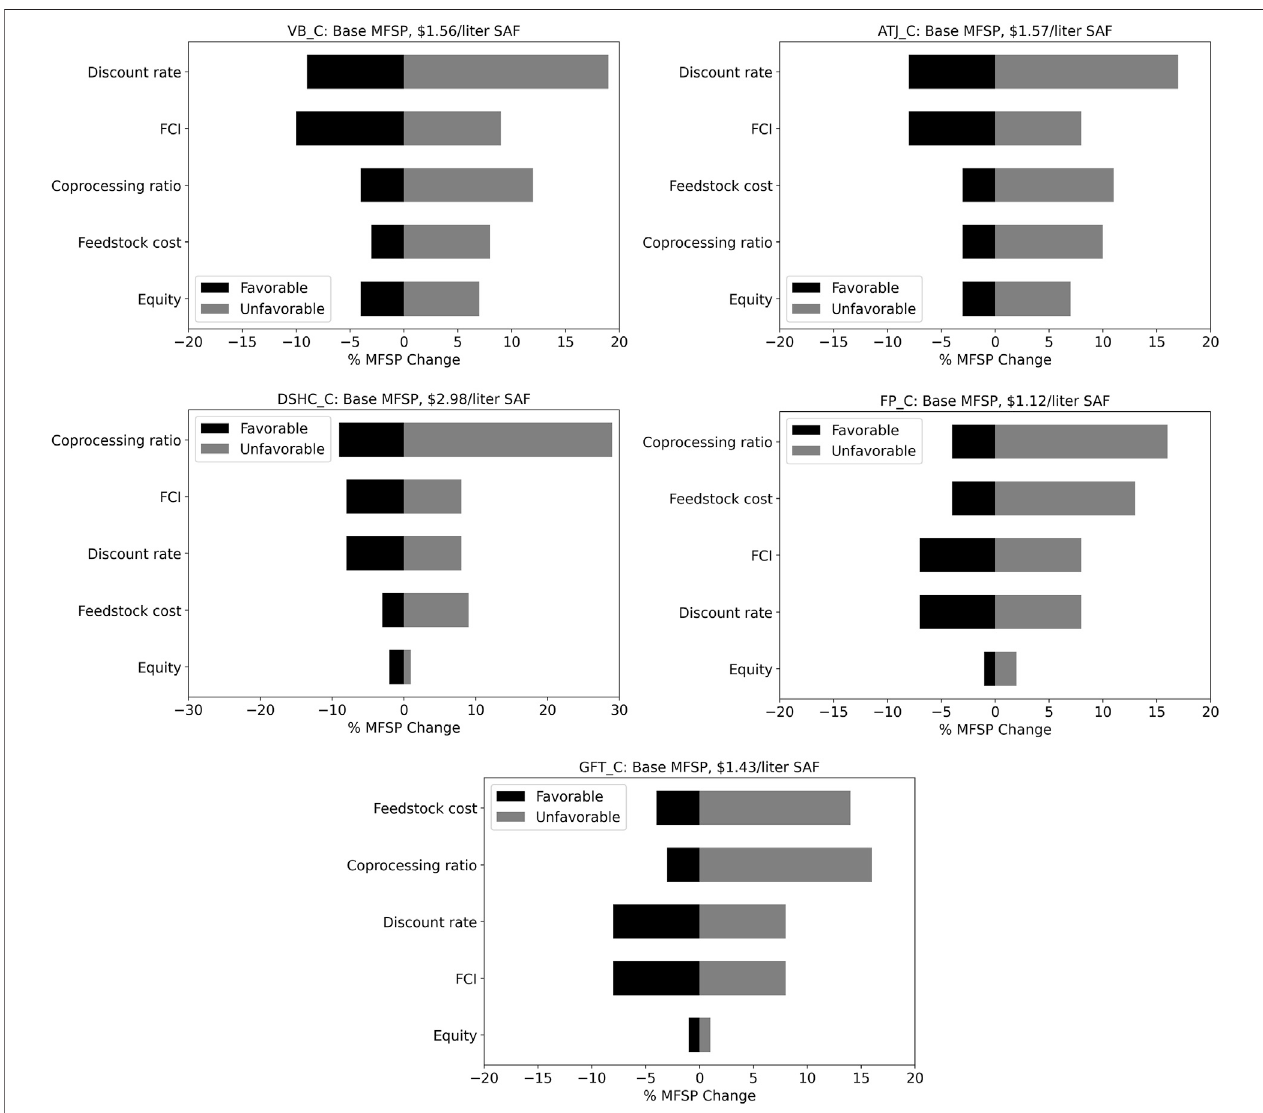
FIGURE 8 | Sensitivity analyses of repurposed